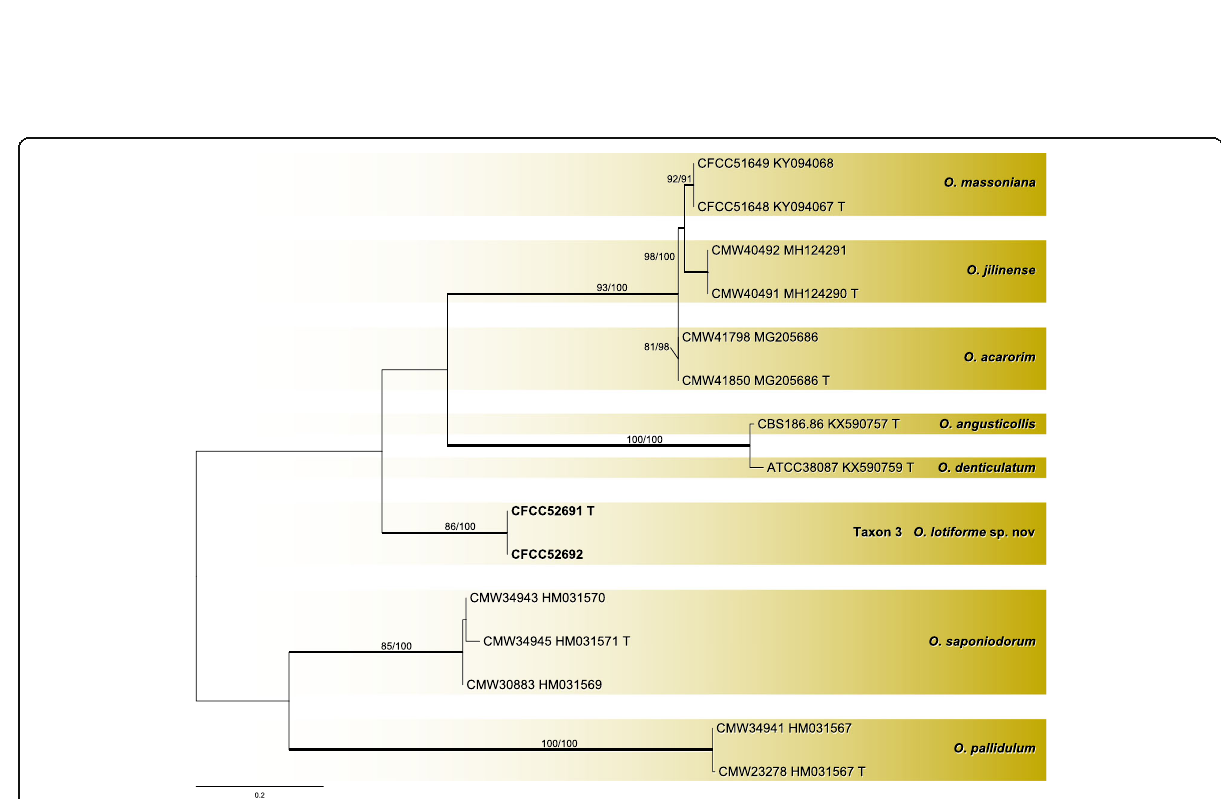
Fig. 10 ML tree of Group A generated from the β T sequence data. Sequences generated from this study are printed in bold. Bold branches indicate posterior probability values ≥ 0.9. Bootstrap values of ML/MP ≥ 70% are recorded at the nodes. T = ex-type isolates